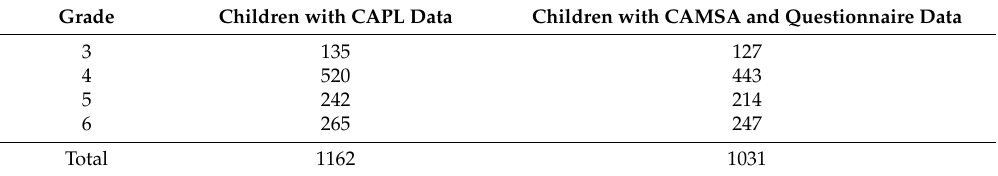
Table 1. Number of children that provided complete Canadian Agility and Movement Skill Assessment (CAMSA) and questionnaire data. CAPL: Canadian Assessment of Physical